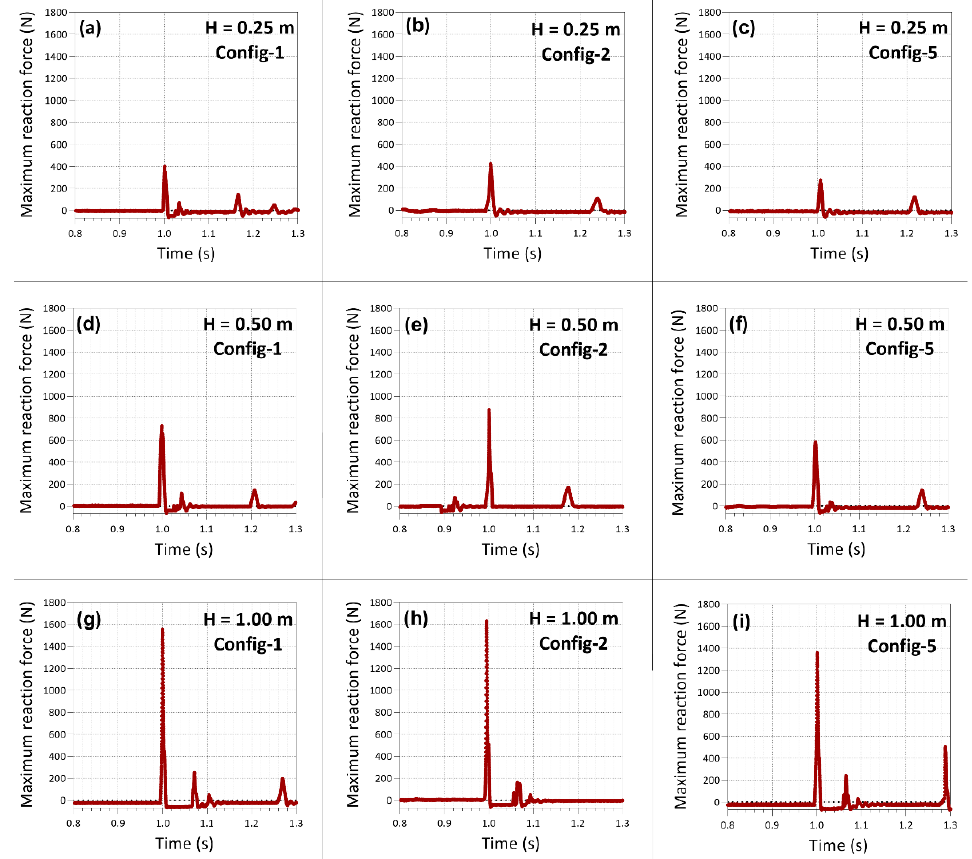
Figure 3. Reaction force curves for various cases. ( a ) Config ‐ 1 for 0.25 m; ( b ) Config ‐ 2 for 0.25 m; ( c ) Config ‐ 5 for 0.25 m; ( d ) Config ‐ 1 for 0.50 m; ( e ) Config ‐ 2 for 0.50 m; ( f ) Config ‐ 5 for 0.50 m; ( g ) Config ‐ 1 for 1.00 m; ( h ) Config ‐ 2 for 1.00 m; ( i ) Config ‐ 5 for 1.00 m.